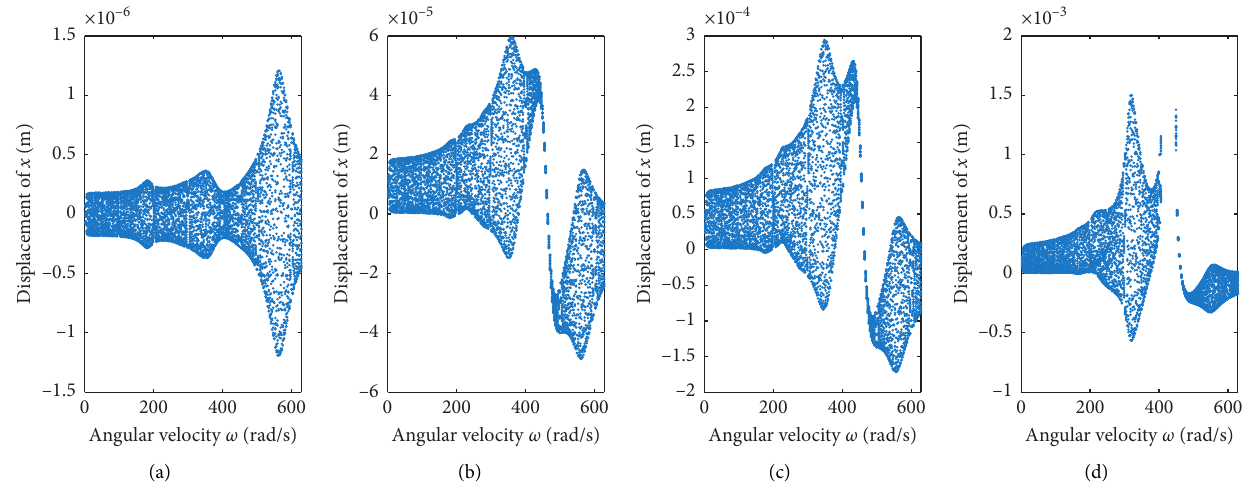
Figure 9: Bifurcation diagram of rotor system with air-gap MMF drop percentage variation at demagnetization angle. (a) ζ � 0, (b) ζ � 20%, (c) ζ � 40%, (d) ζ � 60%.